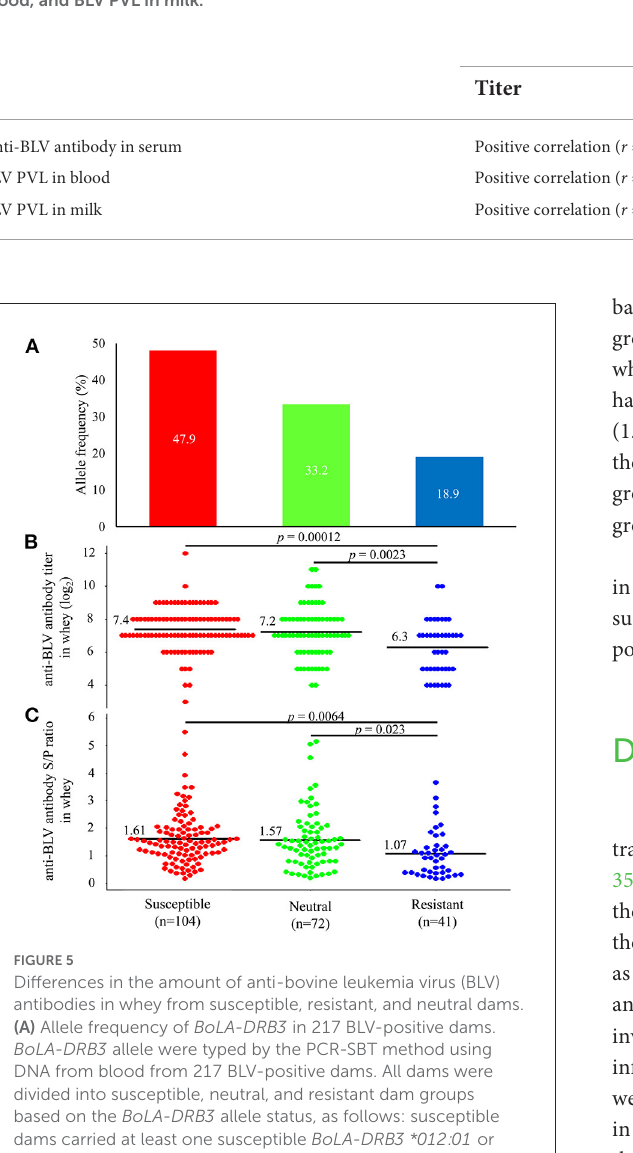
TABLE 2 Positive correlation between the amount of anti-BLV antibodies in whey and the amount of anti-BLV antibodies in serum, BLV PVL in blood, and BLV PVL in milk.